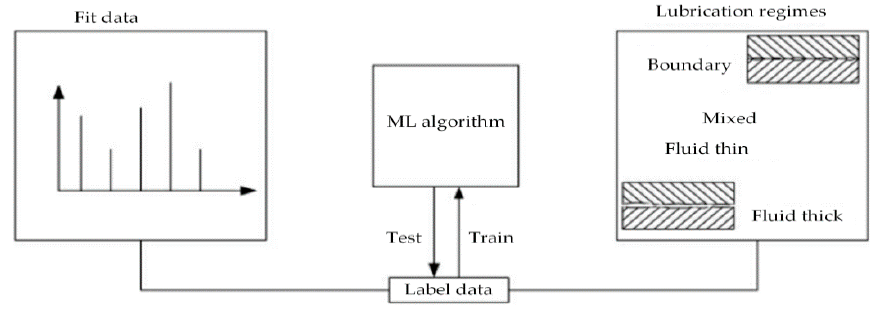
Figure 24. Approach for the classification of lubrication regimes [199].